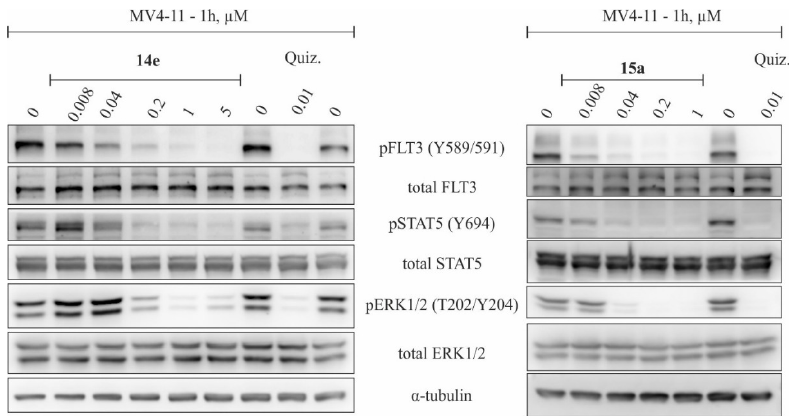
Figure 6. Effect of 14e and 15a on phosphorylation of FLT3 and its downstream signaling pathways. MV4-11 cells were treated for 1 h with indicated concentrations of the compounds; quizartinib (Quiz.) was used as a standard. α -tubulin was used for equal protein loading.